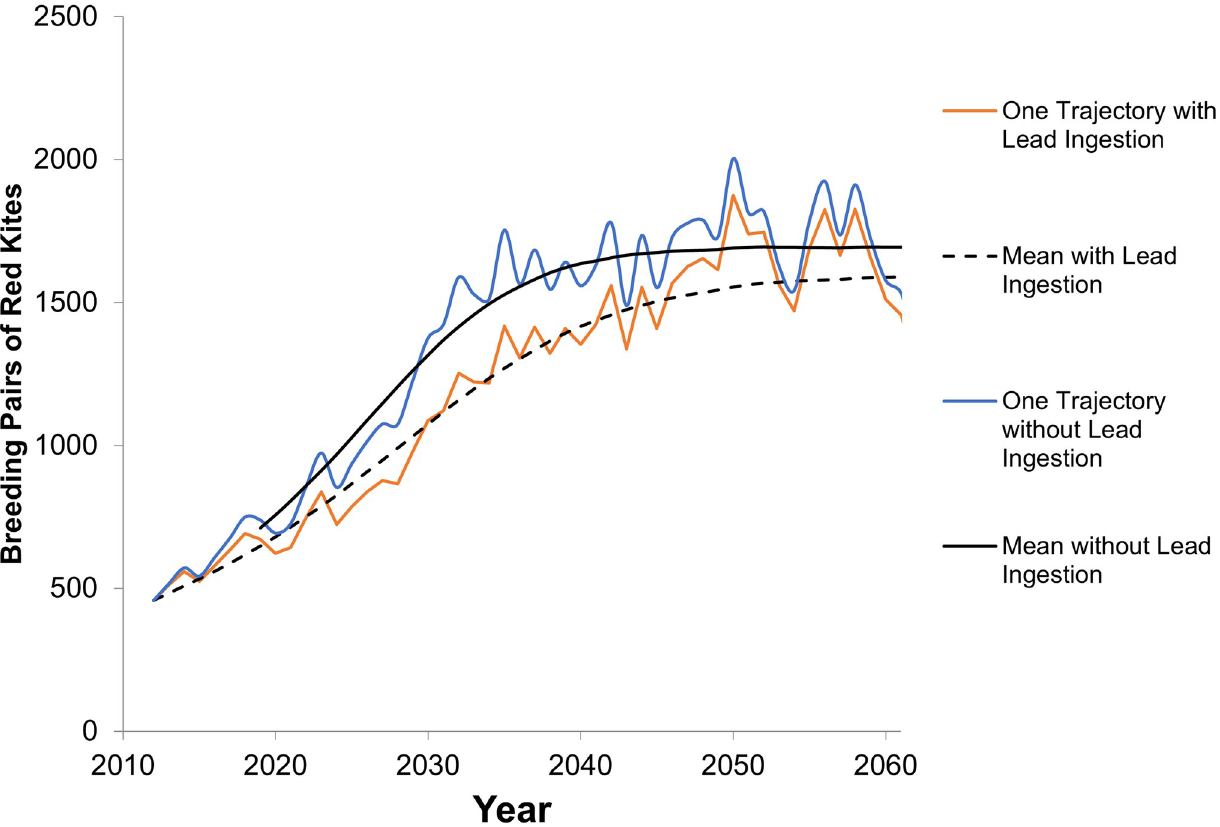
Fig 5. Modeled population trends for red kite with and without lead shot and bullet ingestion. (a) Shown with reproduction effects. In addition to the mean, an example iteration of one of the 10,000 runs is shown in to demonstrate the trend variability.